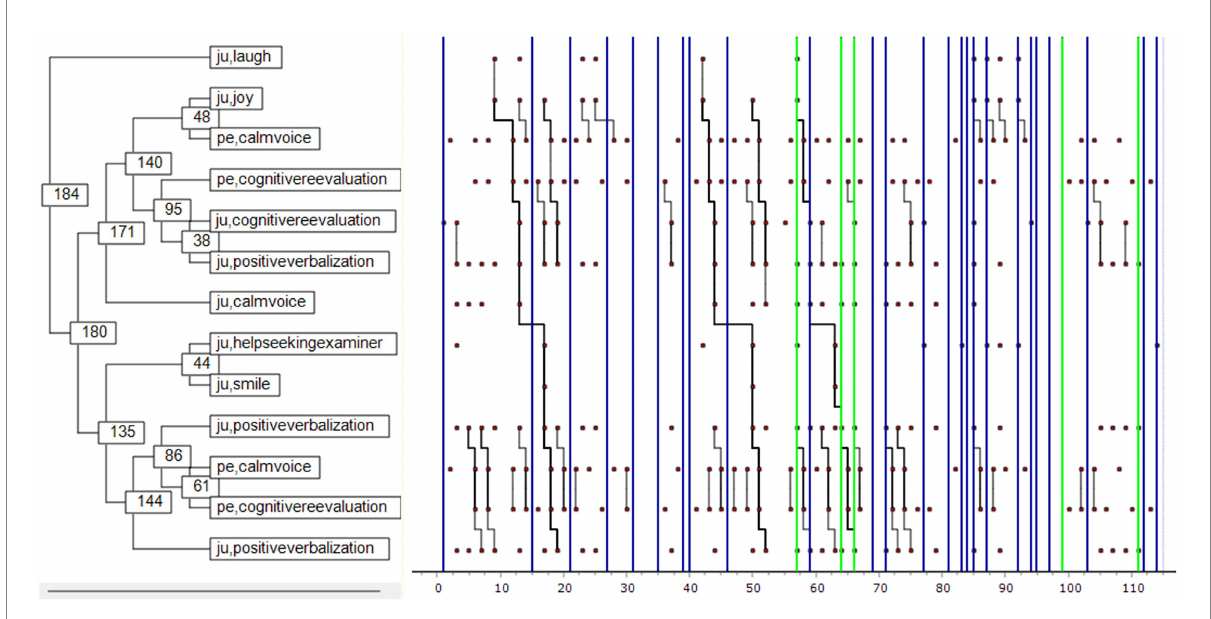
FIGURE 6 Julia-Father interaction pattern. ju : Julia, pe : father. The X-axis shows the number of behavioral units occurring within the selected 2-min interaction (114 acts overall). Green lines highlight the disengagement behaviors and blue lines are related to self-excitement attitudes. The numbers appearing in the left side of the figure are related to an identification number of each node and is not related with the appearing occurrence of each behavior.